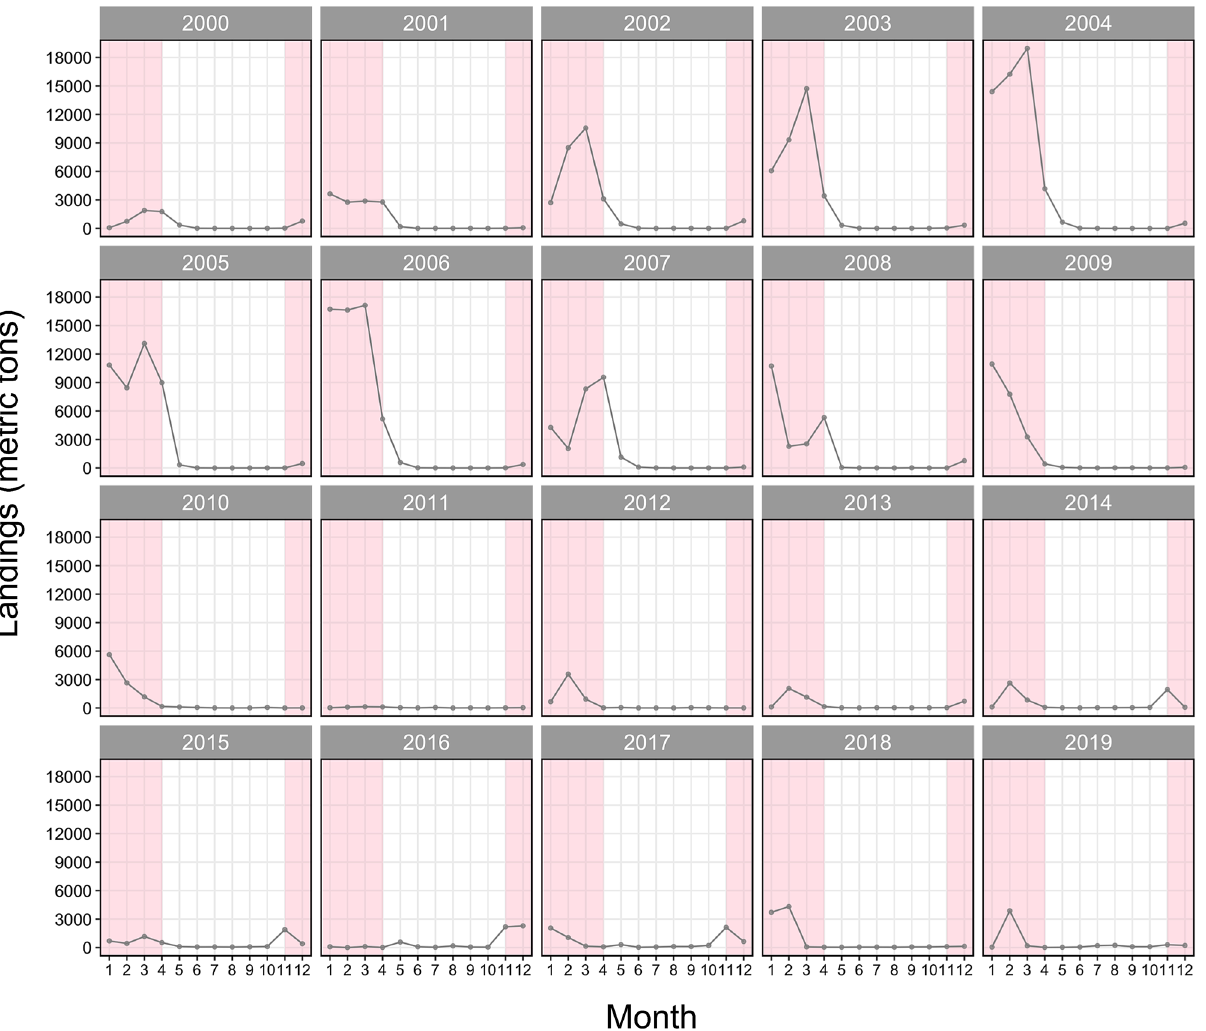
Figure 2. Monthly time series of US commercial mackerel landings from 2000 to 2019. Shaded backgrounds represent months with typically high landings (November–April). Data obtained from National Marine Fisheries Service, Northeast Fisheries Science Center